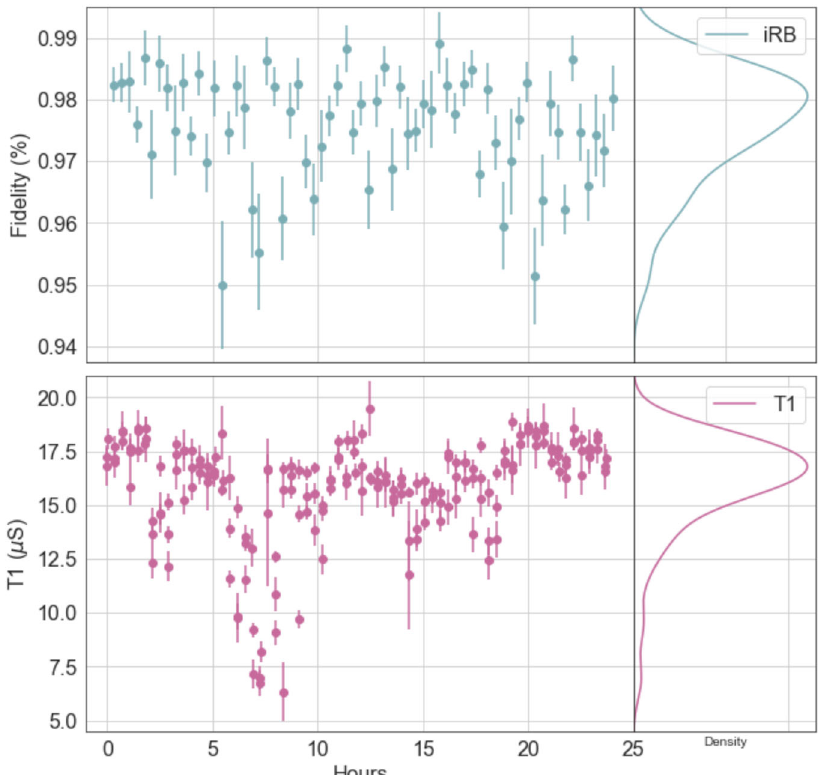
Fig. 8 Timeseries of the iRB fi delity and T 1 of the tunable qubit on the C1-D6 pair. The tunable qubit has a lower T 1 relative to the fi xed qubit on the edge and is thus the limiting factor in regards to incoherent error. The repeated measurement sequence calibrates readout parameters, parks the tunable qubit at its maximum frequency, measures the coherence time and benchmarks the gate. Error bars represent the 95% con fi dence bounds on the fi tted parameter ( fi delity and T 1 ) for each